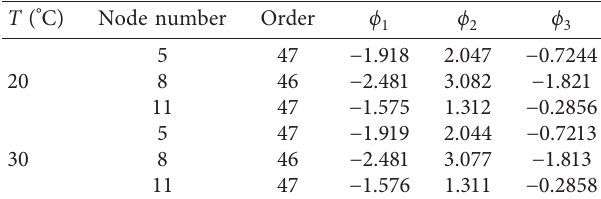
Figure 7: The acceleration signal of the AR model input and predicted output. Table 1: The most suitable AR models for each node of the un- damaged ASCE benchmark structure under 20 ° C and 30 °